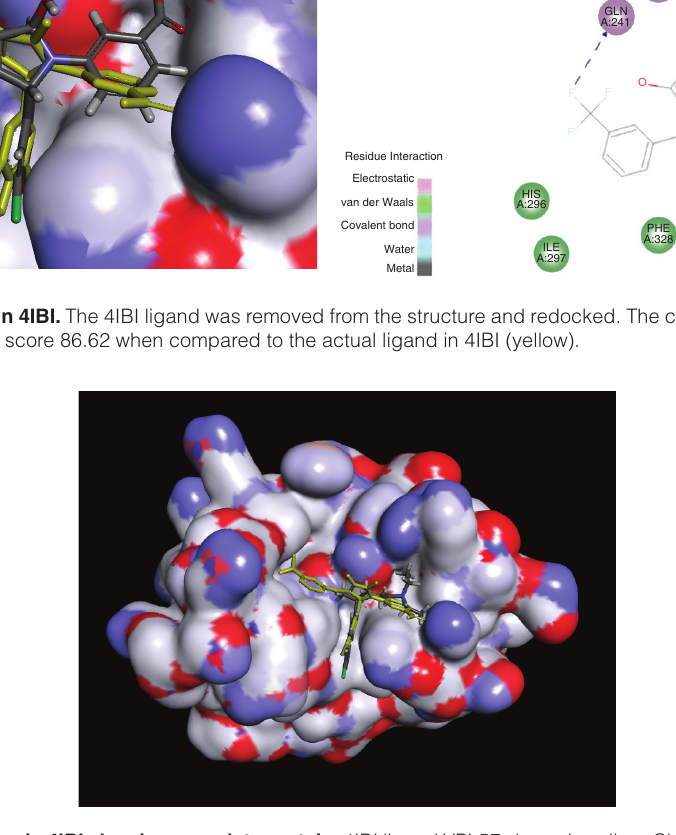
Figure S2. Docking chloroquine in 4IBI showing complete protein. 4IBI ligand VPL57 shown in yellow. Chloroquine (grey). The compounds bind in the first basic patch of the interferon inhibitory domain which is important for the viral nucleoprotein interaction and replication complex formation 15 .